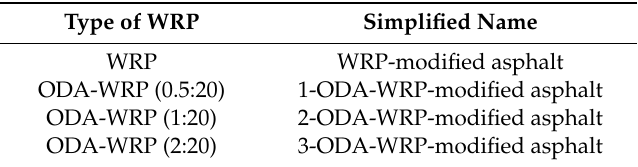
Figure 2. Preparation process of different kinds of WRP/ styrene-butadiene-styrene (SBS)-modified asphalt. Table 1. Modified asphalt composition and terminology of each group having 5% WRP content. 102